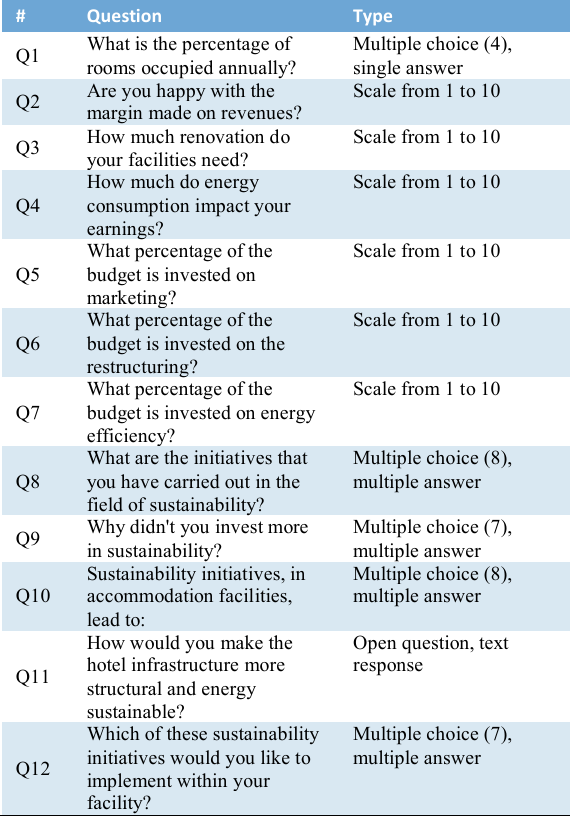
Table 2 - Average occupation level of the hotel